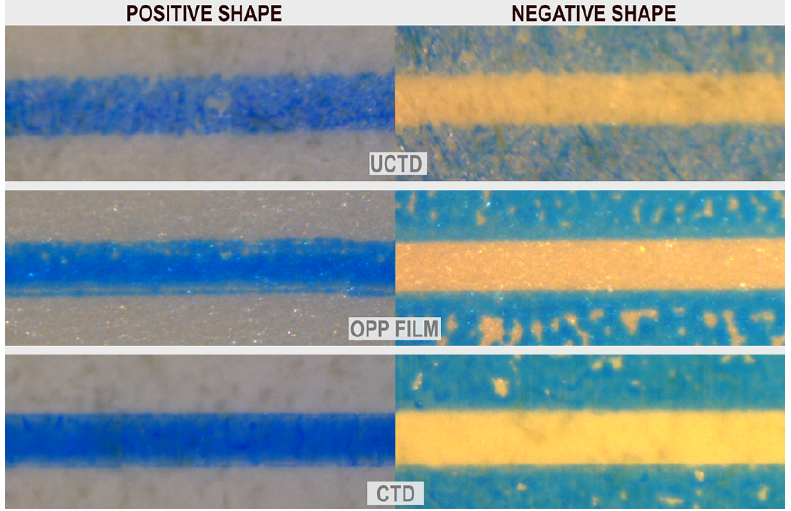
Figure 5. Visual comparison of line edge noise 170 μ m in width printed in positive and negative shapes on three different printing substrates.